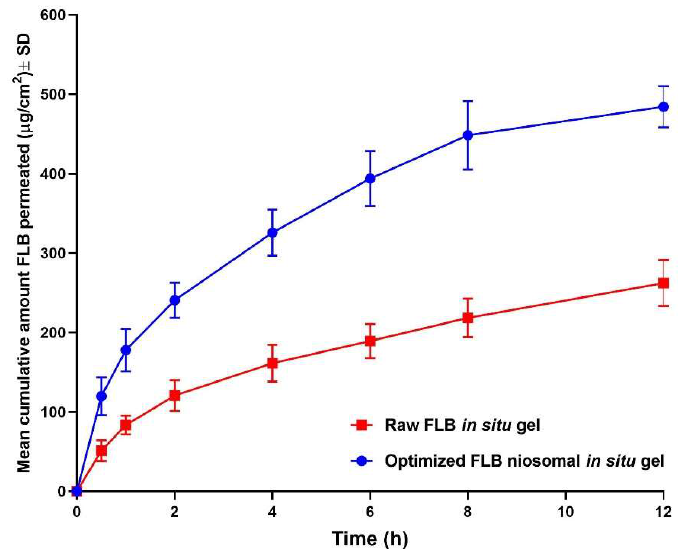
Figure 6. Ex vivo permeation profile of optimized FLB niosomal in situ nasal gel compared to raw FLB in situ gel in simulated nasal fluid, pH 6.5 at 35°C (Results presented as mean ± SD, n = 3).